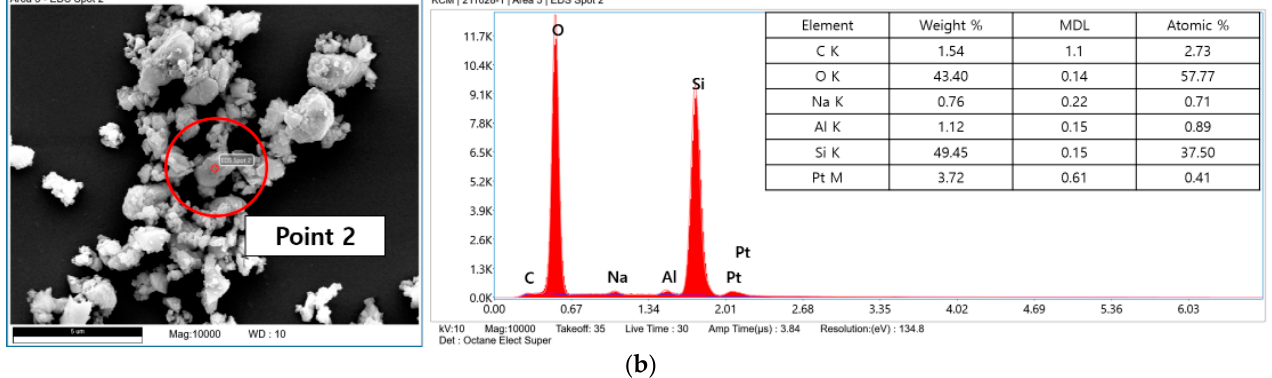
Figure 6. SEM image and particle EDS analysis: ( a ) glass substrate and ( b ) SiO 2 particle. In the LSC process, the damage to the glass substrate needs to be minimized. Thermal damage with the femtosecond laser pulse is typically limited, but accumulated femtosecond pulses can cause thermal damage. We employed over 20,000 laser pulses with a repetition rate of 50 kHz, and the results are shown in Figure 7. Damage was observed in the focal region, and particles were removed from a donut-shaped region with a radius of approximately 300 µ m. Small debris was also observed in the areas far from the focal region of the laser.